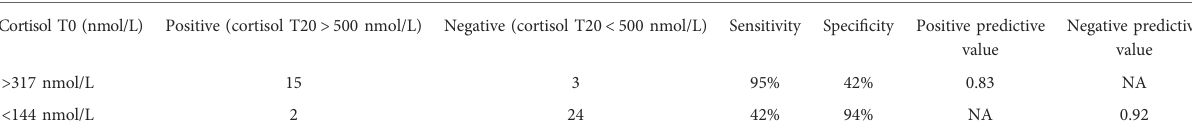
TABLE 2 Frequencies of test outcome depending on the LD-SST result.